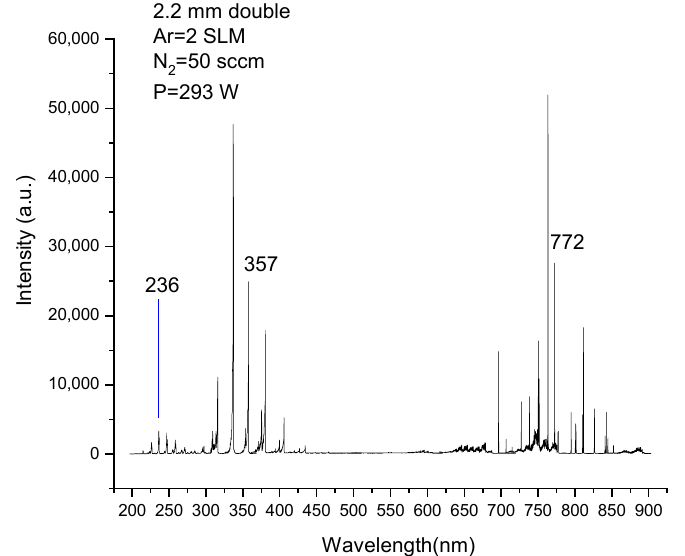
Figure 7. Emission spectra of discharge using argon-doped nitrogen, 236 nm: N 2 ( A 3 ∑ u+ –X 1 ∑ g+ ) , 357 nm: N 2 ( C 3 Π u , 0 – B 3 Π g , 1 ), 772 nm: Argon (2p 7 – 1 s 5 ).